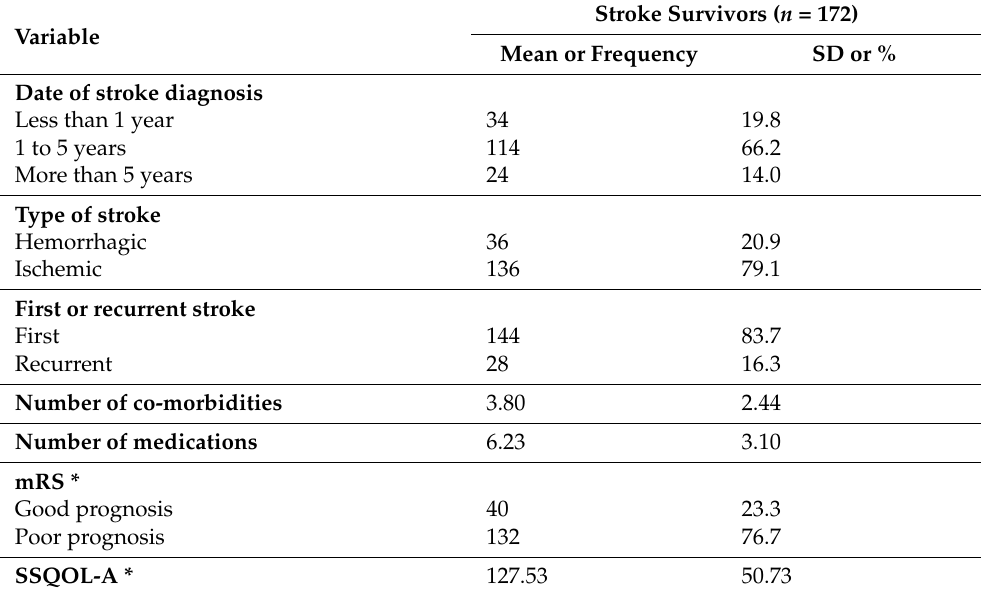
Table 2. Clinical characteristics and stroke parameters of the